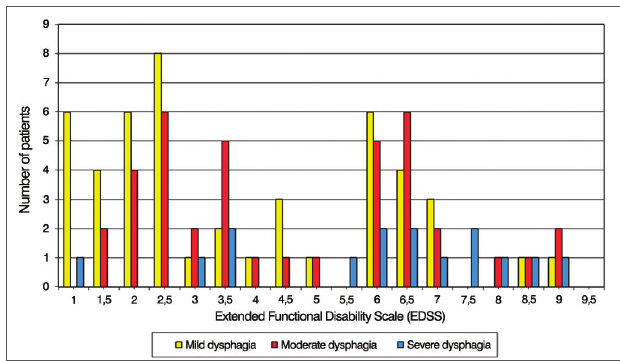
Figure 5. Patient distribution according to the severity of dysphagia and scores on the Extended Functional Disability Scale